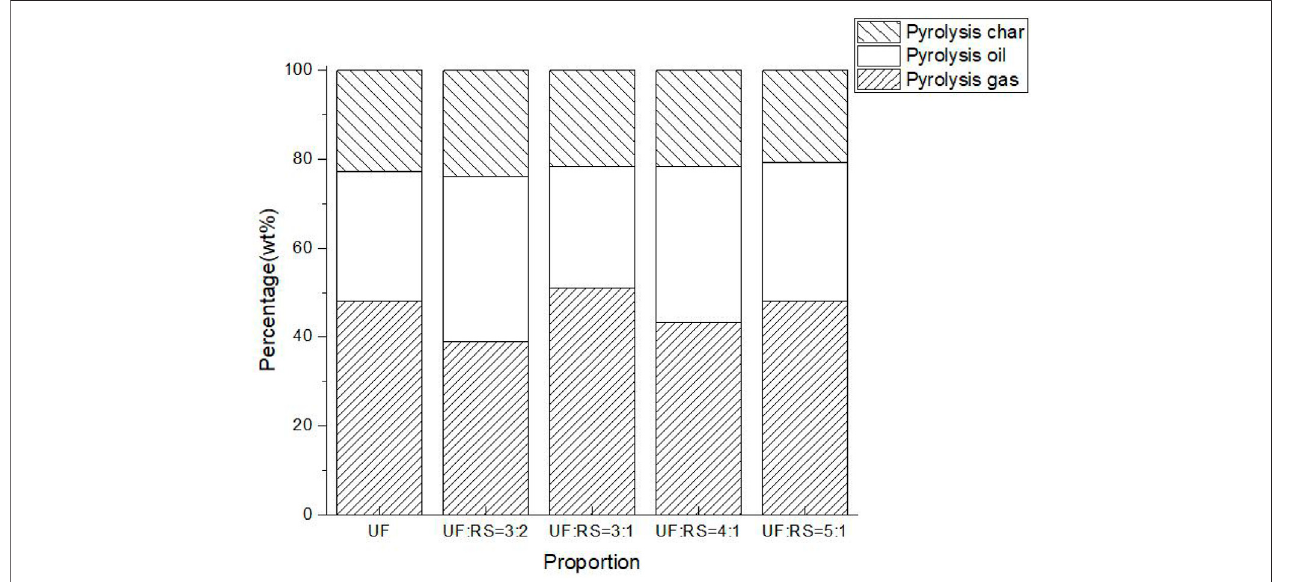
FIGURE 4 | Distribution of three-phase products of samples at 550 ° C with different